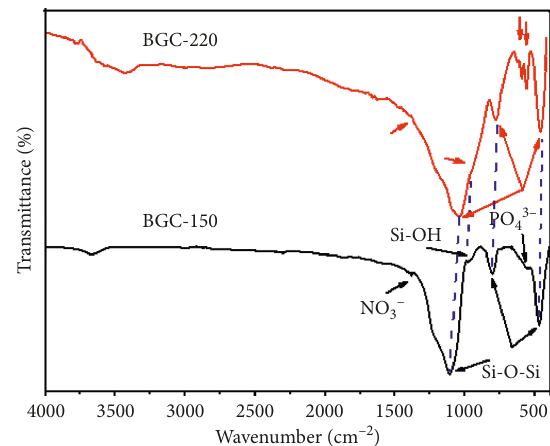
Figure 2: FTIR spectra of BGC-150 and BGC-220 samples.